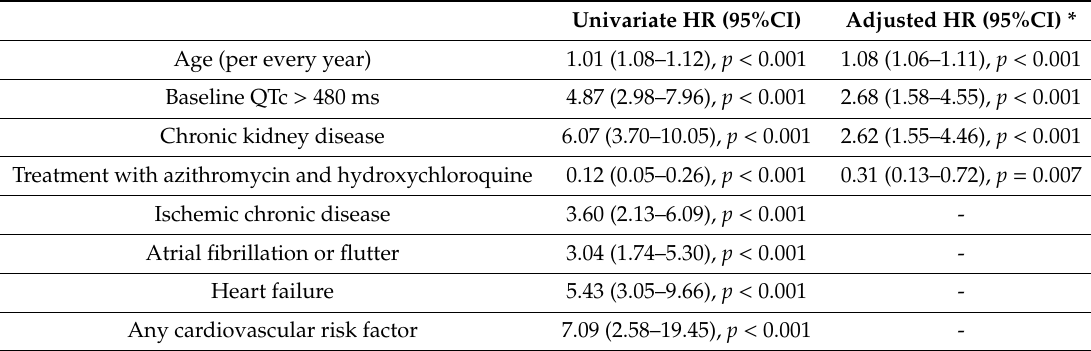
Table6. Hazardratios(HR)of30-daydeathforbaselineQTc > 480msadjustedforpotentialconfounders.